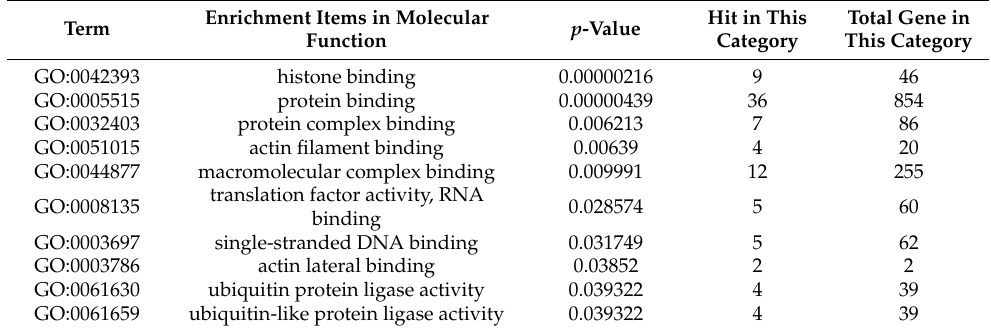
Table 5. Enrichment items in molecular function of gene ontology for protein targets of penetratin. Term